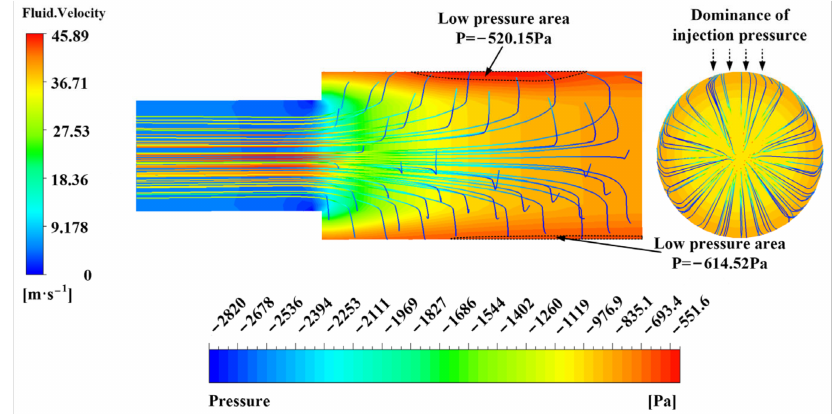
Figure 12. Velocity and pressure distribution of the